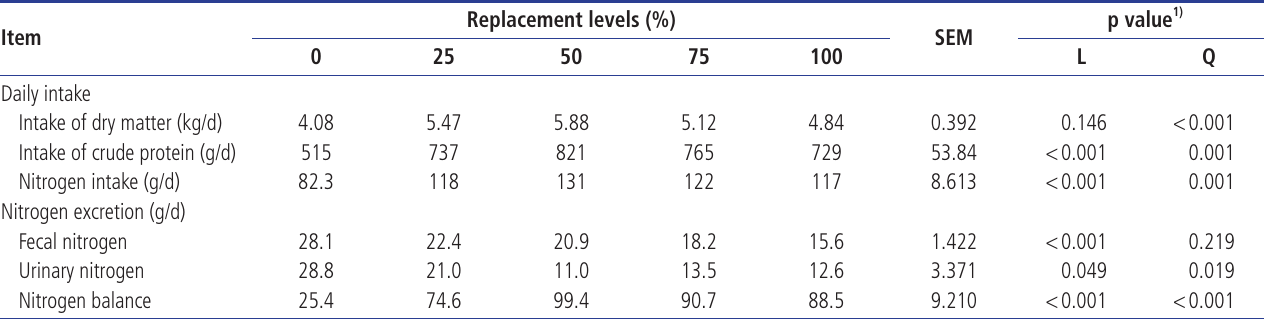
Table 3. Nitrogen intake, excretion and balance for steers fed cactus cladodes plus urea Item